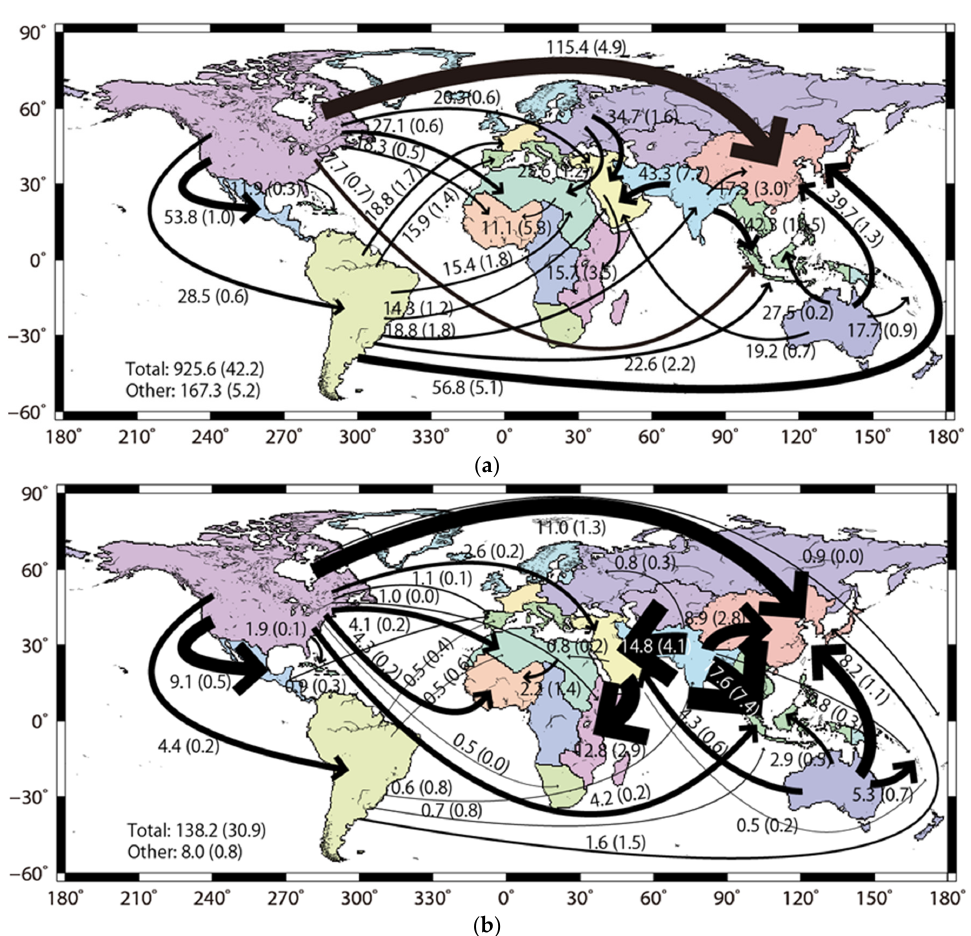
Figure 3. Water scarcity footprint flows due to international food trade between 22 regions for ( a ) all water sources (exceeding 10 km 3 H 2 Oeq/year) and ( b ) groundwater (exceeding 0.5 km 3 H 2 Oeq/year).